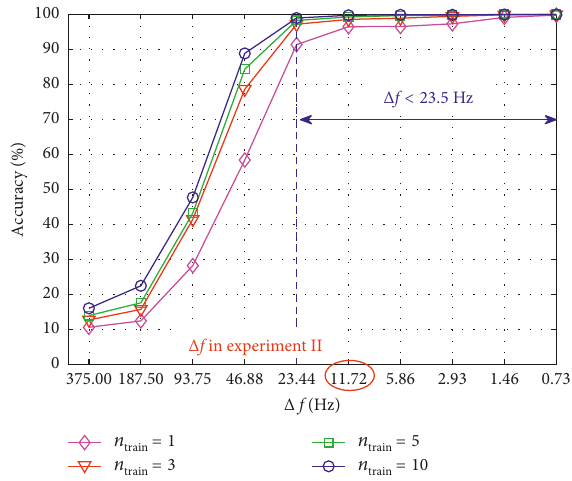
Figure 16: Classification performance of dataset G5 in experiment II with different spectrum